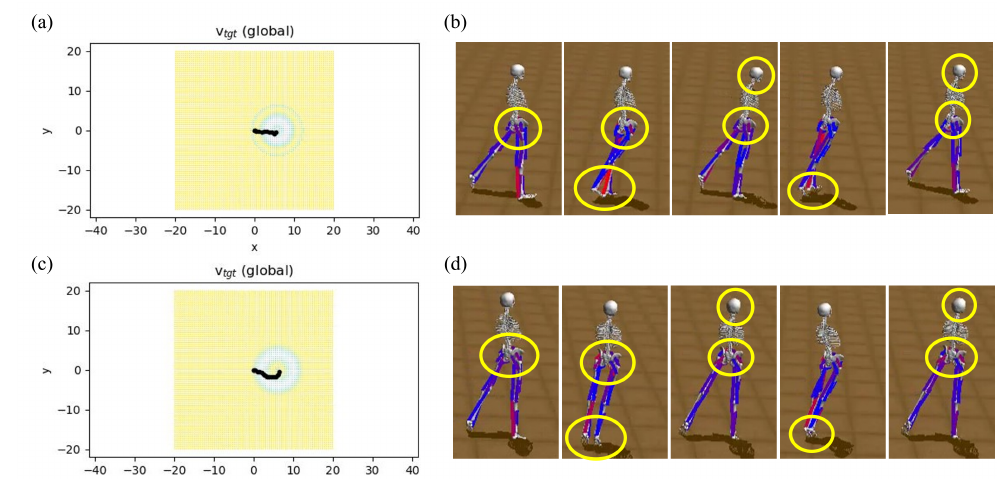
Figure 7. ( a ) The musculoskeletal locomotion trajectory and ( b ) frames for a five-meter straight walk when IMU constraint is used for training. ( c ) The musculoskeletal locomotion trajectory and ( d ) frames for a five-meter straight walk when no IMU constraint is used for training. The highlighted regions in ( b , d ) illustrate that when IMU data are used to train the agent, the body direction is straight. Conversely, when no IMU data are used, the agent walks in an inefficient manner and the direction is not straight, unlike a normal human.